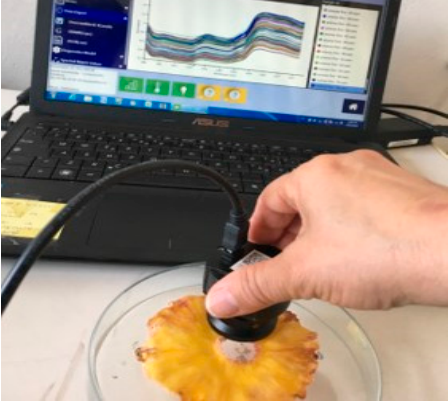
Figure 1. The microNIR1700 (VIAVI Solutions, CA, USA) at work.